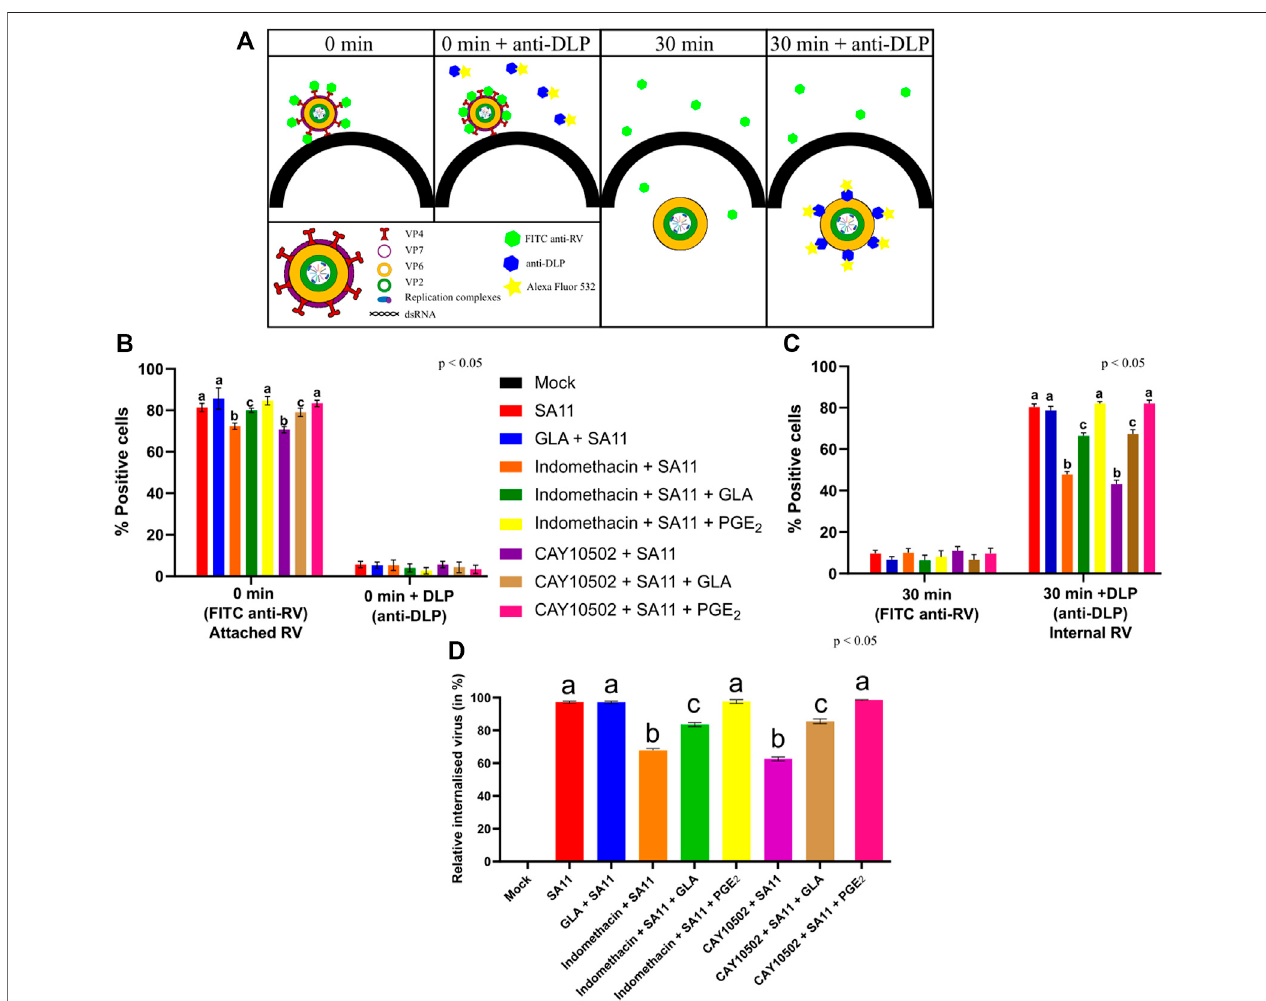
FIGURE 5 | Inhibition of PGE2 biosynthesis affects RV attachment and internalisation. (A) At time zero, RV at an MOI = 10 is cold-bound to MA104 cells and is visualised by anti-RV-FITC labelling, which detected the outer capsid protein VP7. When labelling with anti-double-layered particle (DLP) is applied, virus at the cell surface cannot be detected asthe antibodies target themiddle-layer protein, VP6, which isonly accessible after the outer layer has been shed. Thus, the signal intensity of 0 min + anti-DLP is strongly reduced compared to 0 min + anti-RV due to the inability to detect VP6. When the temperature is increased, RV is internalised and the loss of the outer capsid allows for the detection of VP6, i.e., DLPs, to be accessible for staining. (B) Graph showing a higher positive detection of anti-RV-FITC compared to anti-DLP at 0 min. (C) Graph showing a higher positive detection of anti-DLP compared to anti-RV-FITC at 30 min. (D) Relative percentage of internalised virusfromuntreatedandinhibitor-treatedcellsat30 minpost-infectioniscalculatedbydividingtherelativeinternalisedRV(30 min) (C) byrelativeattachedRV(0 min) (B) . Error bars indicate the standard error of the mean ( n = 3). Lowercase letters indicate signi fi cant differences ( p < 0.05) compared to the control.